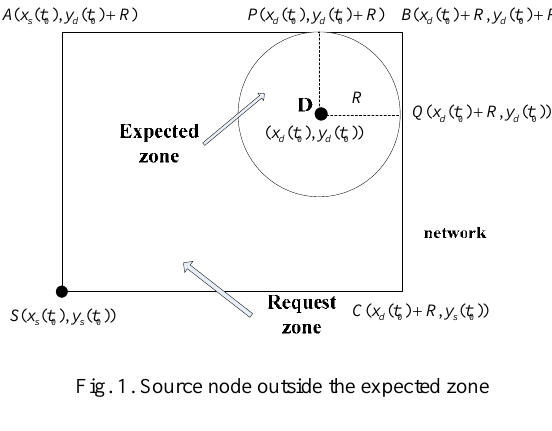
algorithm 6 aims at solving unstructured search problems